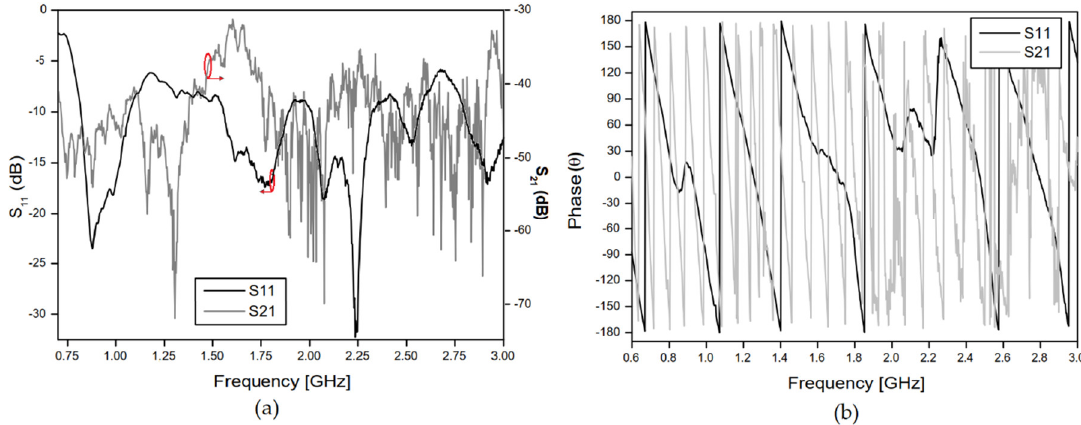
Figure 7. Reflection (S11) and transmission (S21) coefficients’ measured results for the free space measurement setup: ( a ) Magnitude; ( b ) Phase in degrees.